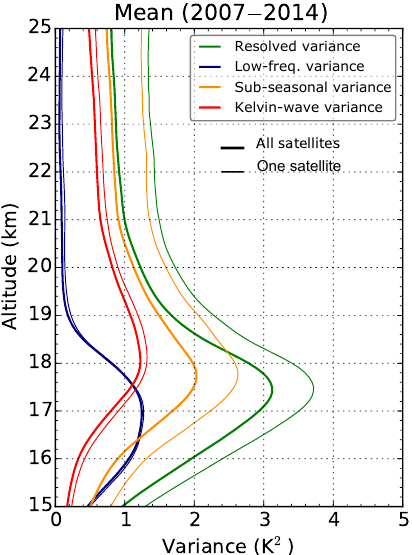
Figure 6. Mean of resolved variance (green), low-frequency vari- ance (blue), sub-seasonal variance (orange), and Kelvin-wave vari- ance (red) as a function of altitude from 15 to 25km. Statistics of variances based on all satellite measurements are shown with thick lines, and statistics of variances based on single satellite measure- ments are shown with thin lines. All statistics were obtained from January 2007 to December